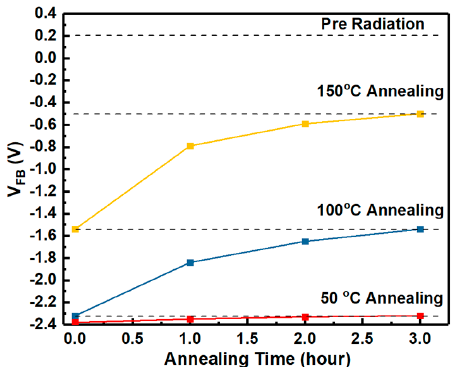
ff erent stages of the isochronal annealing. Nanomaterials 2020 , 10 , x FOR PEER REVIEW